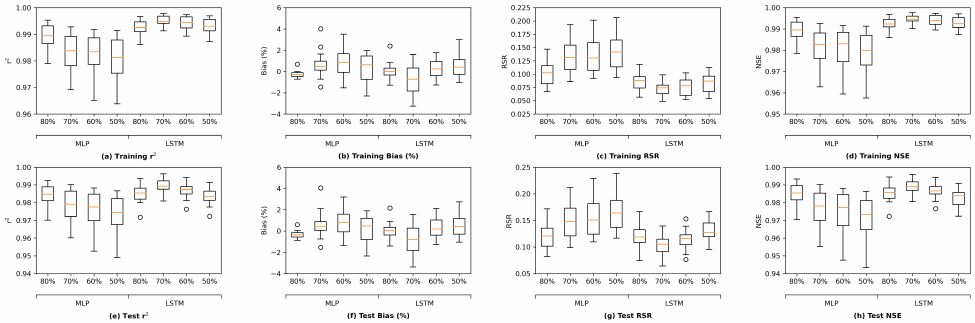
Figure A13. Box and whisker plots of four types of metrics consisting of r 2 , percent bias, RSR, and NSE on stations belonging to the interior Delta group during the training (panels ( a – d )) and test (panels ( e – h )) phases of the grouped (G) MLP and LSTM models under four scenarios with varying lengths of training data: 50%, 60%, 70%, and 80% of all the data available.